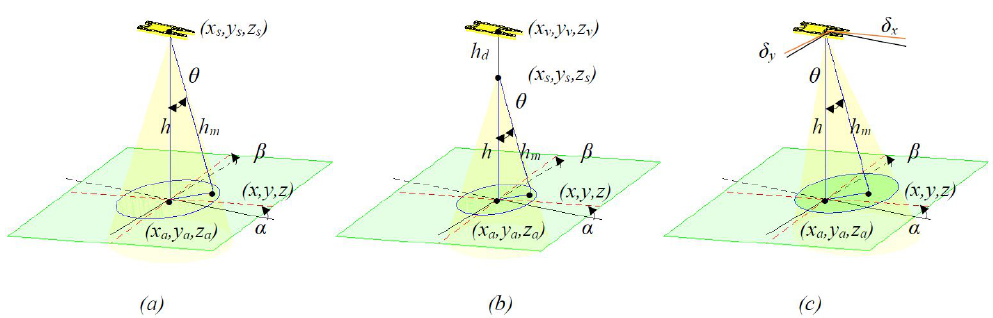
Figure 3. ( a ) Depth measurement without external disturbances and draft of echosounder at the inclined seafloor. ( b ) Depth measurement with a draft of the echosounder at inclined seafloor. In this situation, the echosounder is below the sea surface by an amount of h d . ( c ) Depth measurement with external disturbances in the x and y axes ( δ x and δ y ) at the inclined